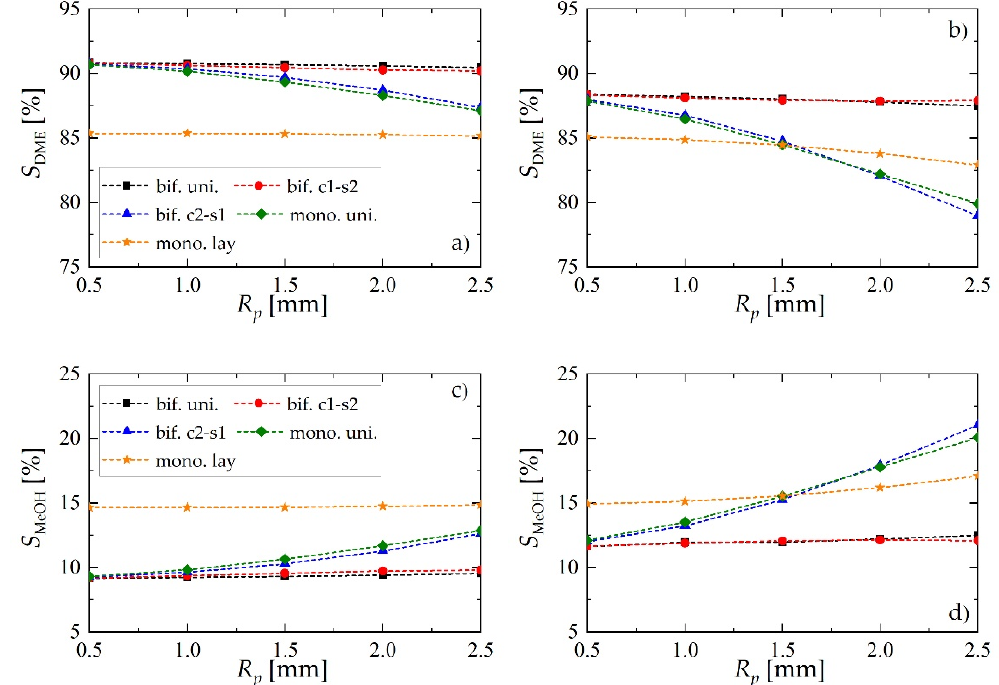
Figure 7. Selectivity of dimethyl ether and methanol obtained using different reactor- and pellet-level structuring of catalytic active sites: ( a ) selectivity of DME for u in = 0.05 m·s −1 ; ( b ) selectivity of DME for u in = 0.1 m·s −1 ; ( c ) selectivity of MeOH for u in = 0.05 m·s −1 ; ( d ) selectivity of MeOH for u in = 0.1 m·s −1 .